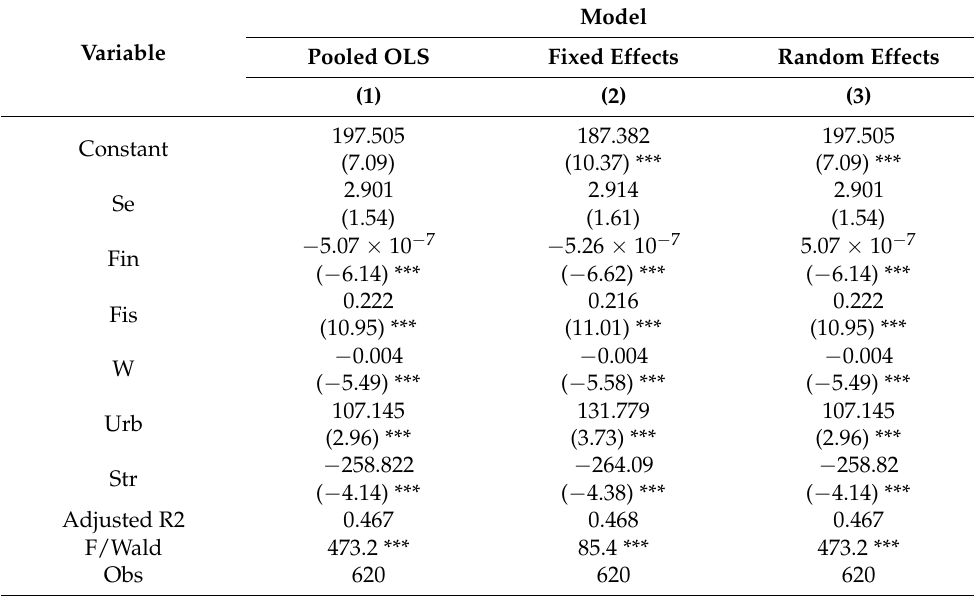
Table 2. Estimation results of panel data